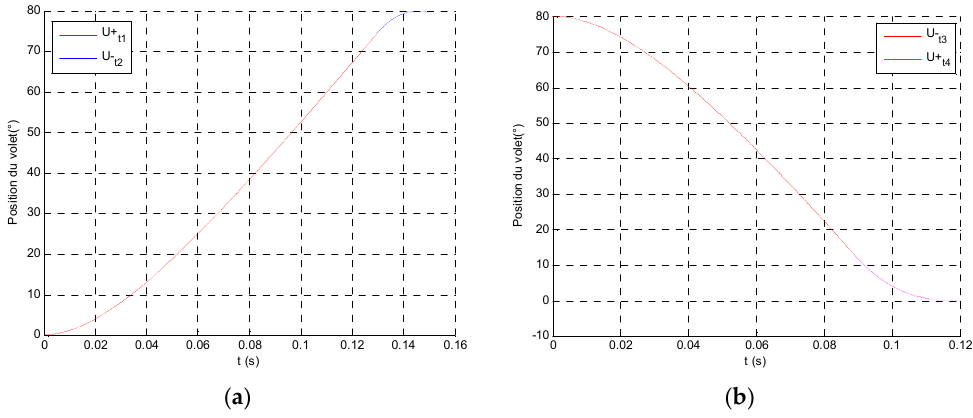
Figure 9. The uniform accelerating and decelerating trajectories; ( a ) forward and ( b ) backward travels.